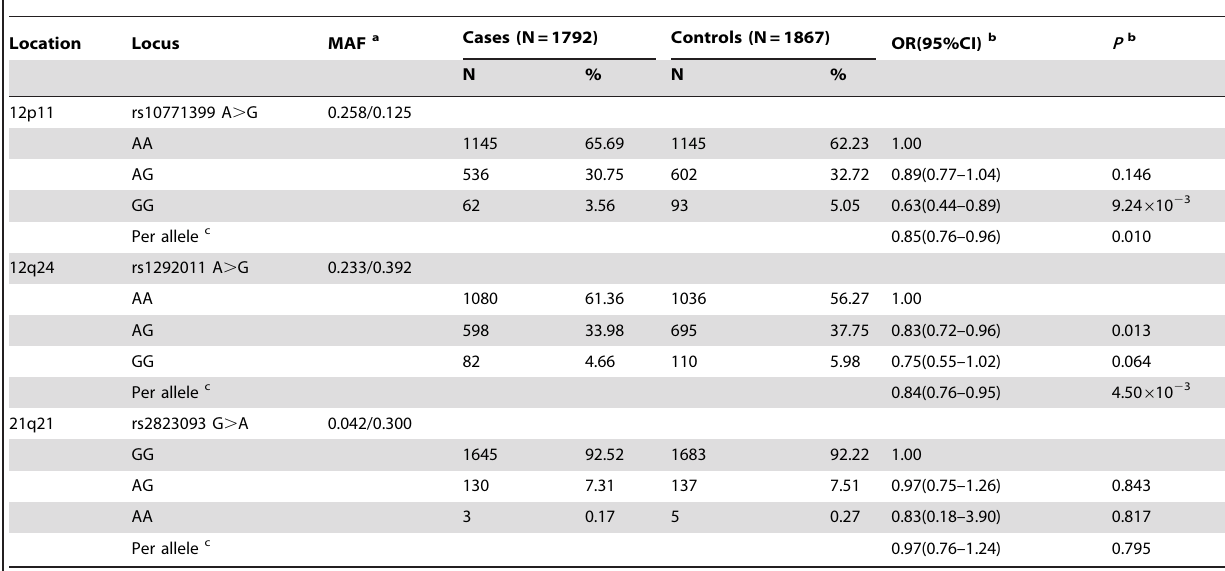
Table 2. The associations of three loci at 12p11, 12q24 and 21q21 with breast cancer risk.